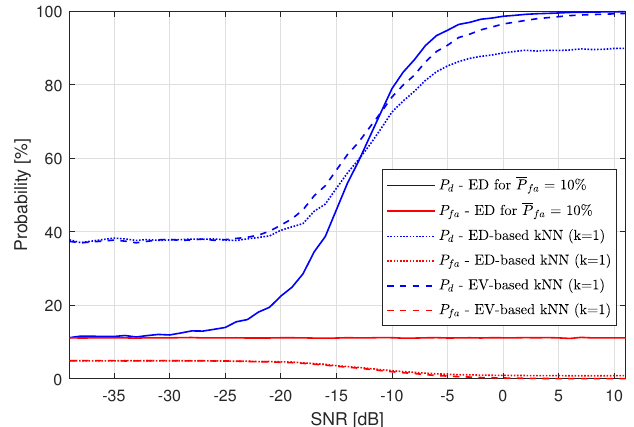
Figure 16. Resulting probabilities P d and P fa of Energy Detection-based k-Nearest Neighbors compared with Energy Vector-based k-Nearest Neighbors for ¯ P fa = 10% for different SNR values with a shadowing